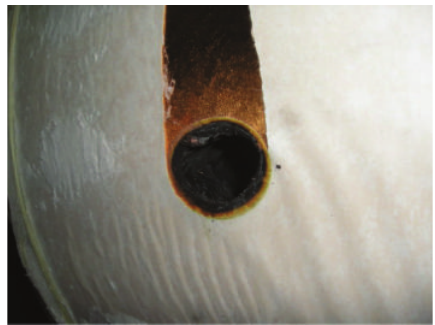
Figure 1: The effect of repetitive overvoltages on a transformer winding.